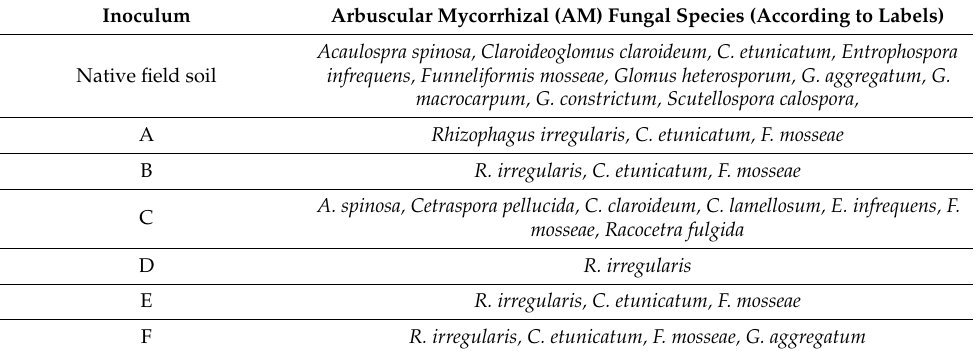
Table 2. Arbuscular mycorrhizal (AM) fungal species of native field soil and each commercial inoculum product, as listed by product